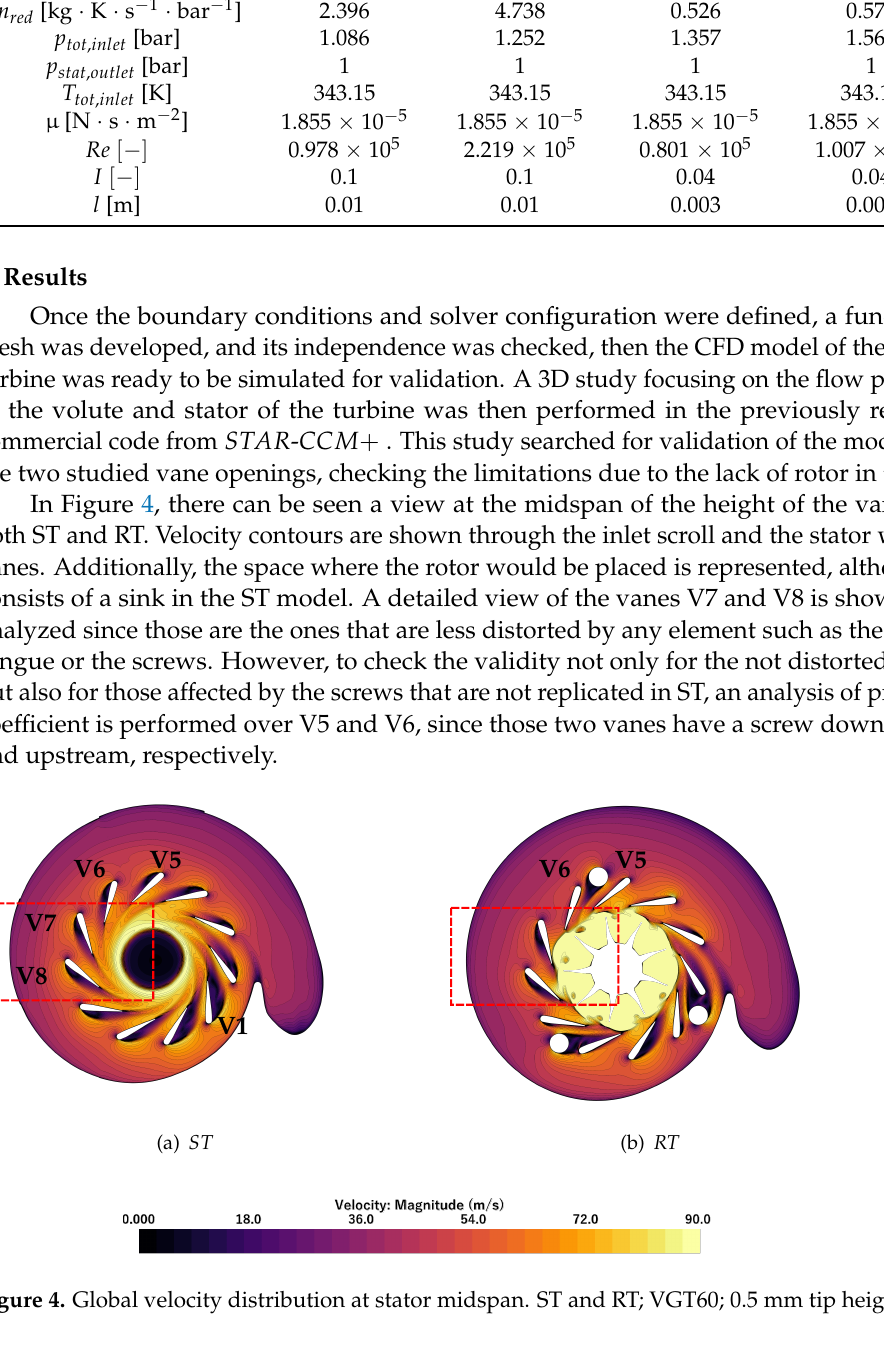
Table 3. Boundary conditions. VGT30.